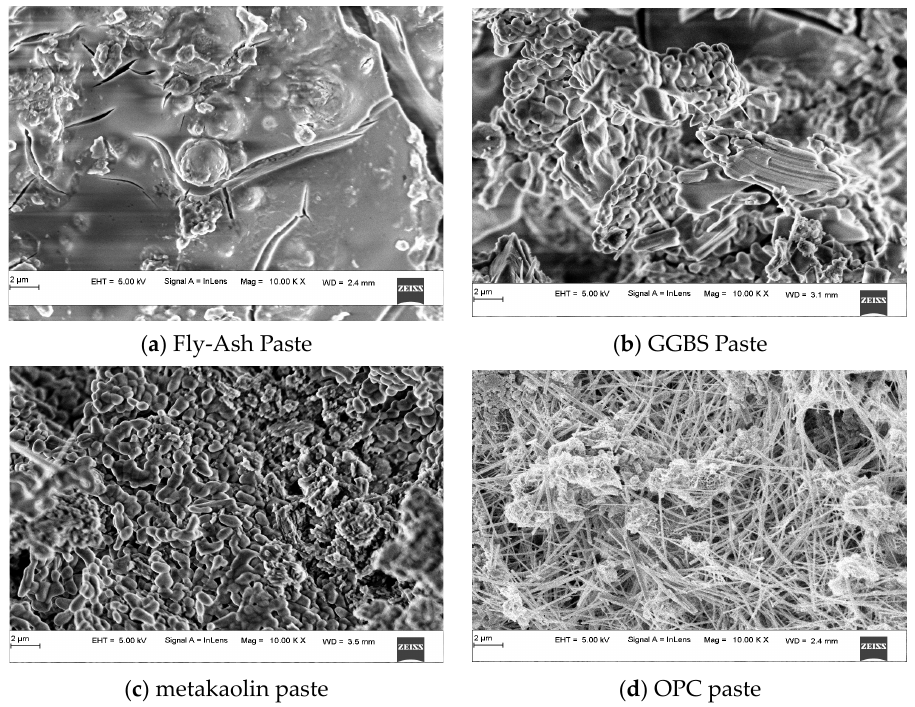
Figure 10. Alkali-activated paste at 7th days with magni fi cation 10 KX.